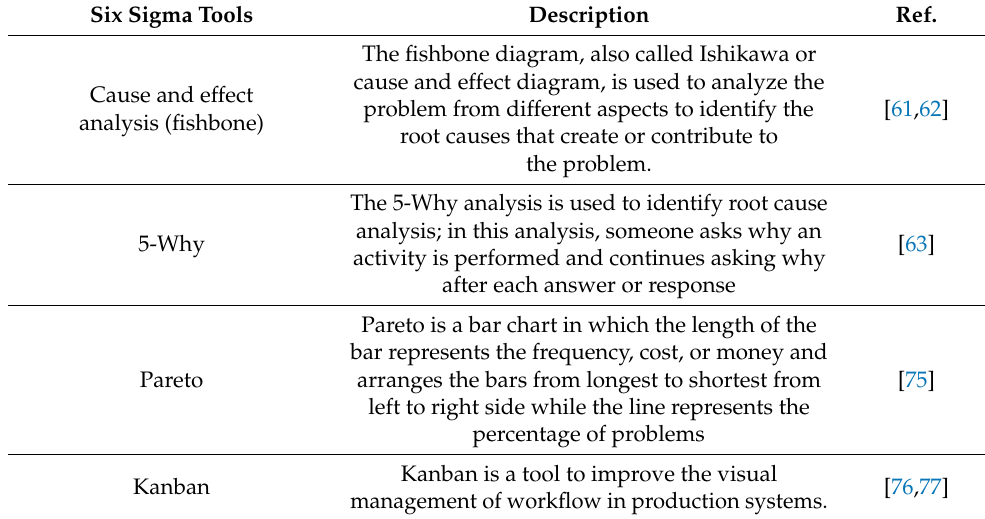
Table A3. Tools used for Six Sigma.